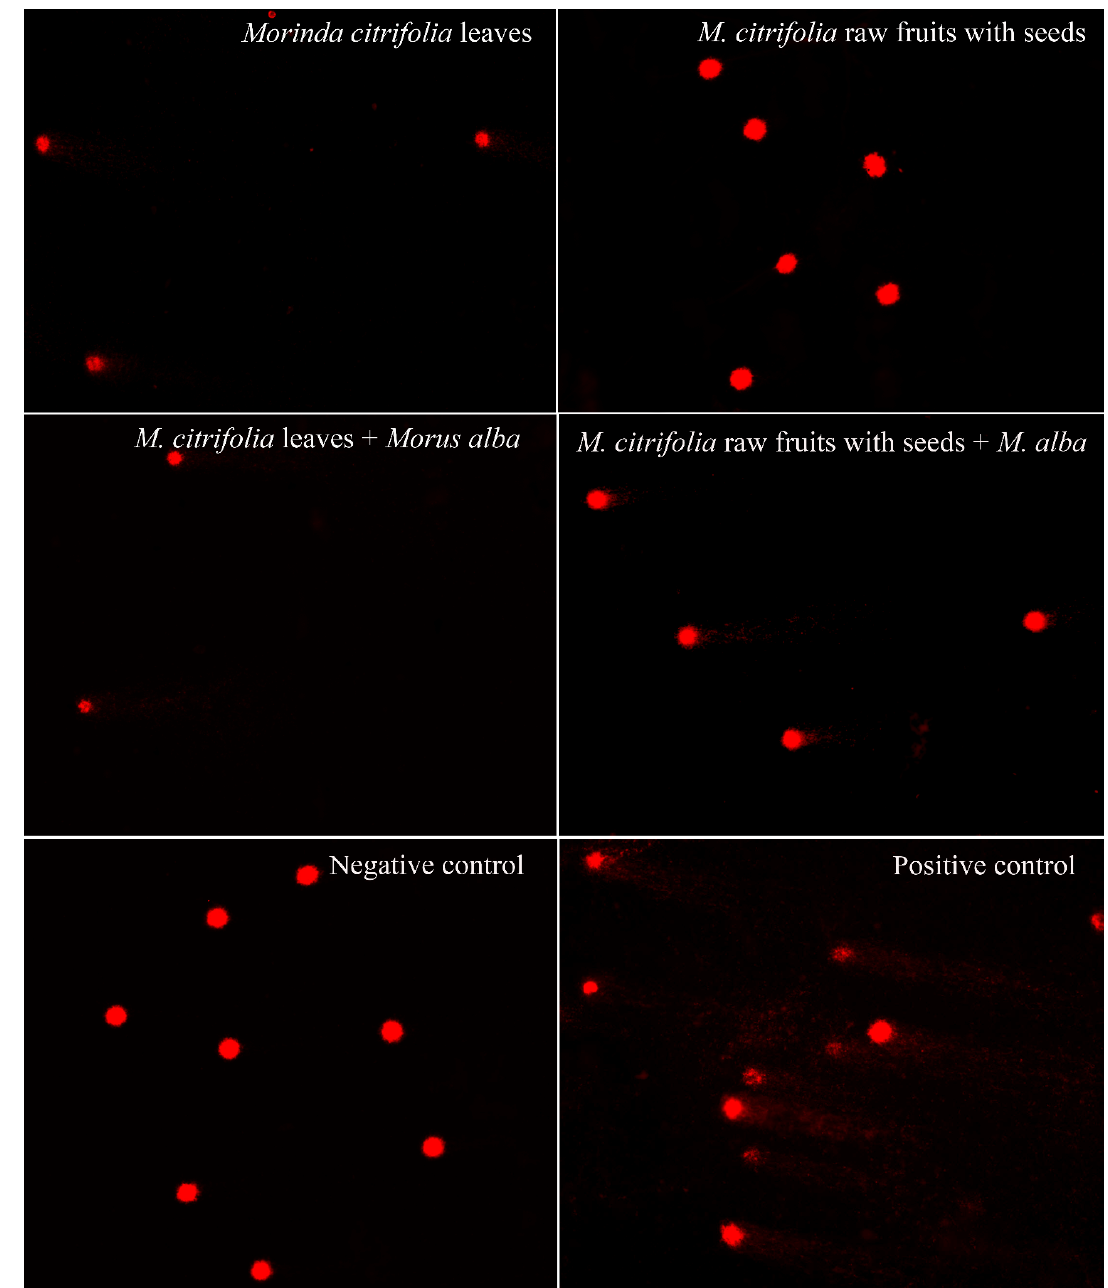
Figure 8. Comet images (200 × ) of PBMCs treated with ethanol extract of Morinda citrifolia leaves, M. citrifolia rawfs, M. citrifolia leaves plus Morus alba , M. citrifolia rawfs plus M. alba extracts; negative and positive